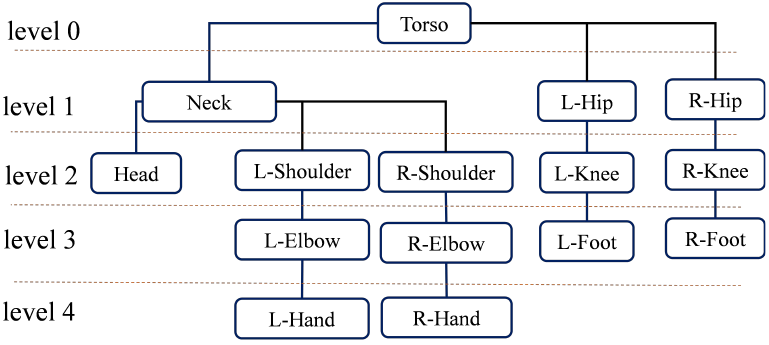
Figure 3. Division of human joints. The level of each joint is denoted on the left